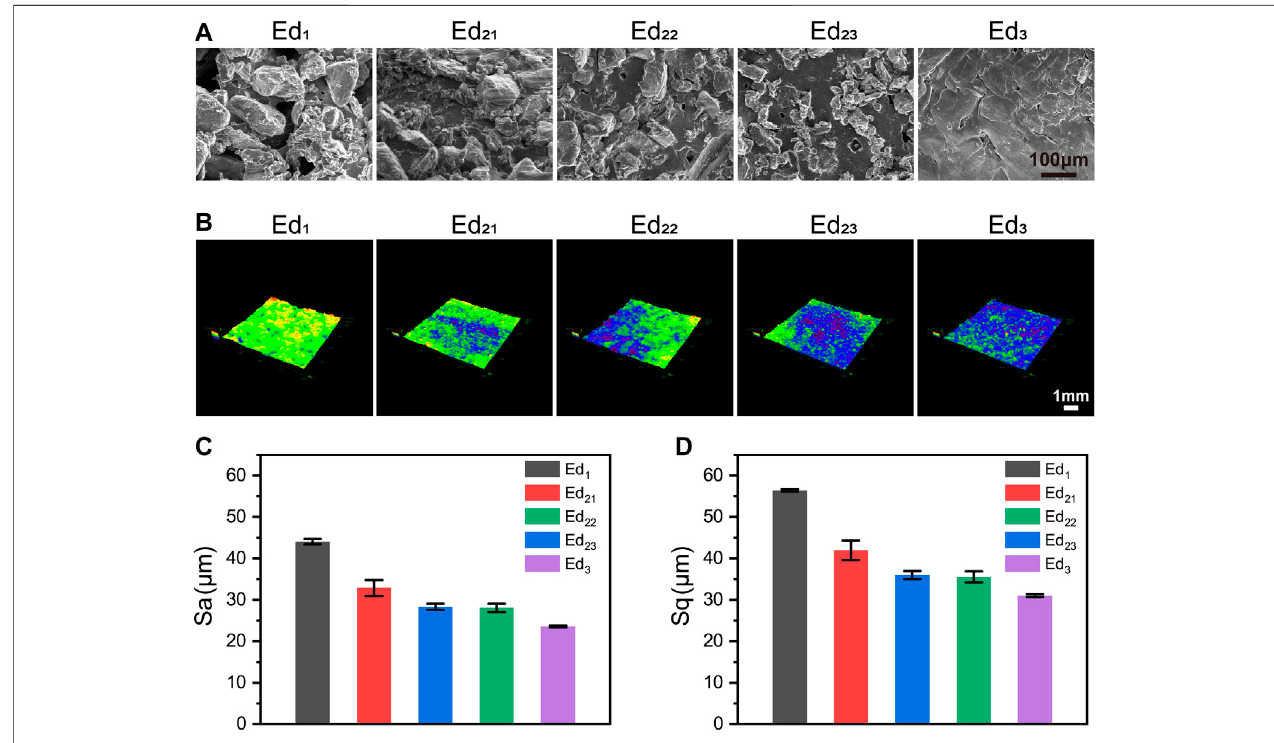
FIGURE 5 | Characterizations of SR with different SLS parameters. (A) Surface SEM images of scaffolds; (B) 3D morphology; (C) Sa and (D) Sq statistical of the samples ’